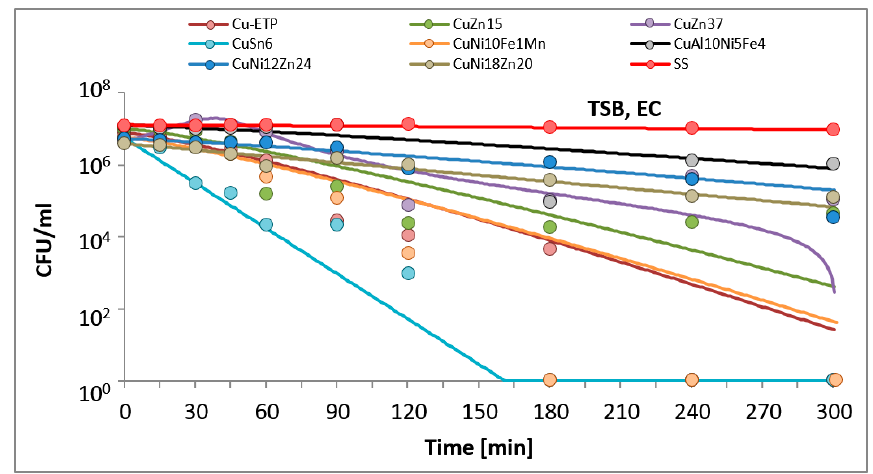
Figure 1. Escherichia coli (EC) suspension density (CFU/mL) reduction on tested metallic materials, in the variant of the experiment simulating organic contamination. TSB, tryptic soy broth.